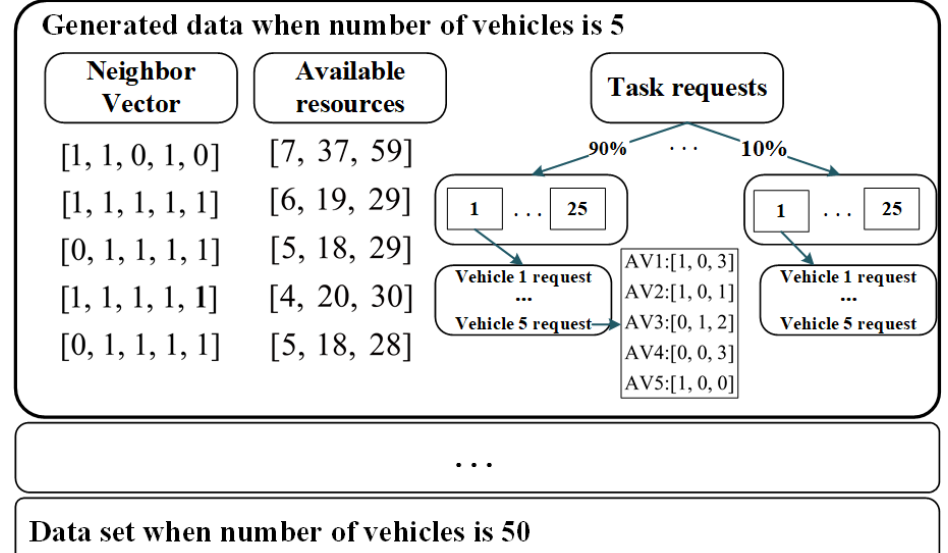
Figure 5. Diagram of the generated dataset.